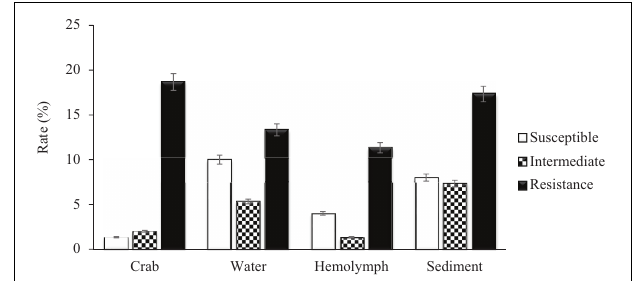
FIGURE 3 | Percentage of Vibrio parahaemolyticus susceptible, intermediate and resistant to